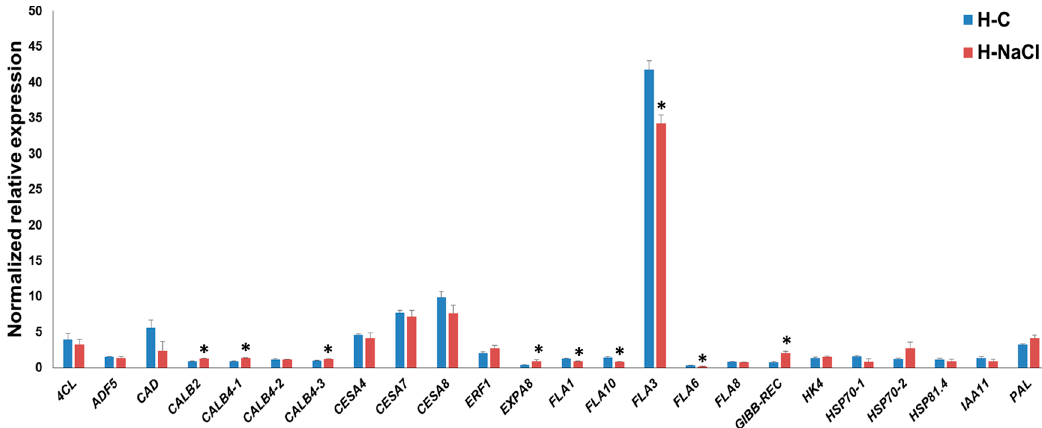
Figure 3. RT-qPCR of hemp hypocotyls under control (H-C) and NaCl exposure (H-NaCl). The asterisks (*) indicates statistically significant differences calculated with the Student’s t -test ( p < 0.05).